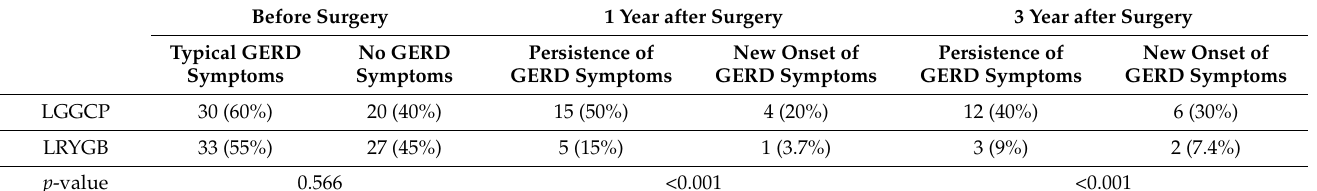
Table 5. GERD before and after surgery.